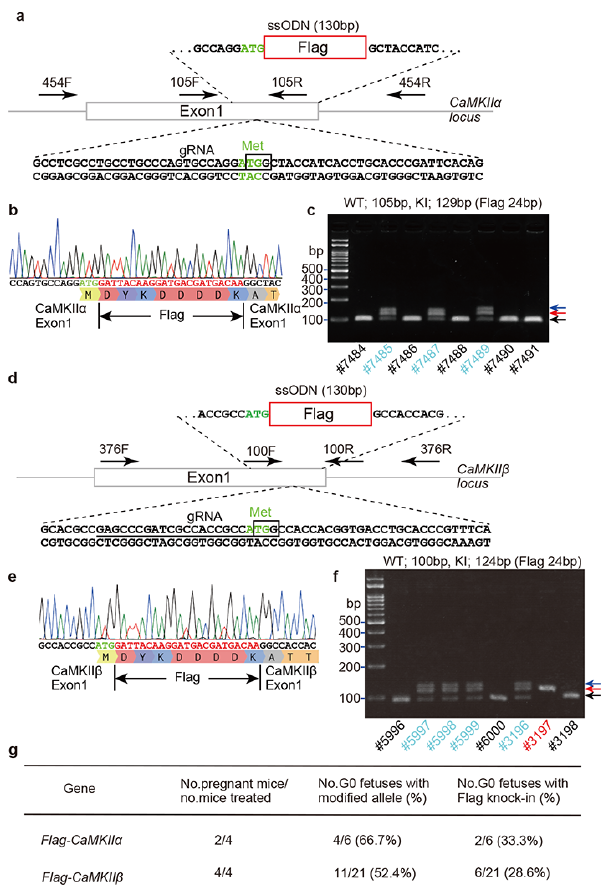
Figure 2. Generation of Flag knock-in mice for CaMKII α and CaMKII β . ( a ) Sequence of exon 1 of mouse CaMKII α , gRNA target site (black underline), and ssODN. The square box shows protospacer adjacent motif (PAM) sequence. The start codon encoding methionin (Met) is highlighted with green. ( b ) Confirmation of knock-in sequences. PCR products using genomic DNA as a template were cloned and sequenced. ( c ) Gel electrophoresis of PCR products amplified with primer sets of CaMKII α - Ex1-105F/R in ( a ). Black and blue colored IDs indicate wild-type (WT) and knock-in (KI) pups, respectively. Black, red, and blue arrows show wild-type (105 bp), KI (129 bp) and heteroduplexed band of wild-type and KI DNA fragments, respectively. ( d – f ) Sequence of exon 1 of mouse CaMKII β , gRNA target site (black underline), and ssODN. Square box shows PAM sequence. The start codon encoding methionin (Met) is highlighted with green. ( e ) Confirmation of knock-in sequences. ( f ) Gel electrophoresis of PCR products amplified with primer sets of CaMKII β -Ex1-100F/R in ( d ). Black- and blue-colored IDs indicate wild-type (WT) and knock-in (KI) pups, respectively. Black, red, and blue arrows show WT (100 bp), KI (124 bp) and heteroduplexed band, respectively. ( g ) A summary table of generating flag knock-in mice by i